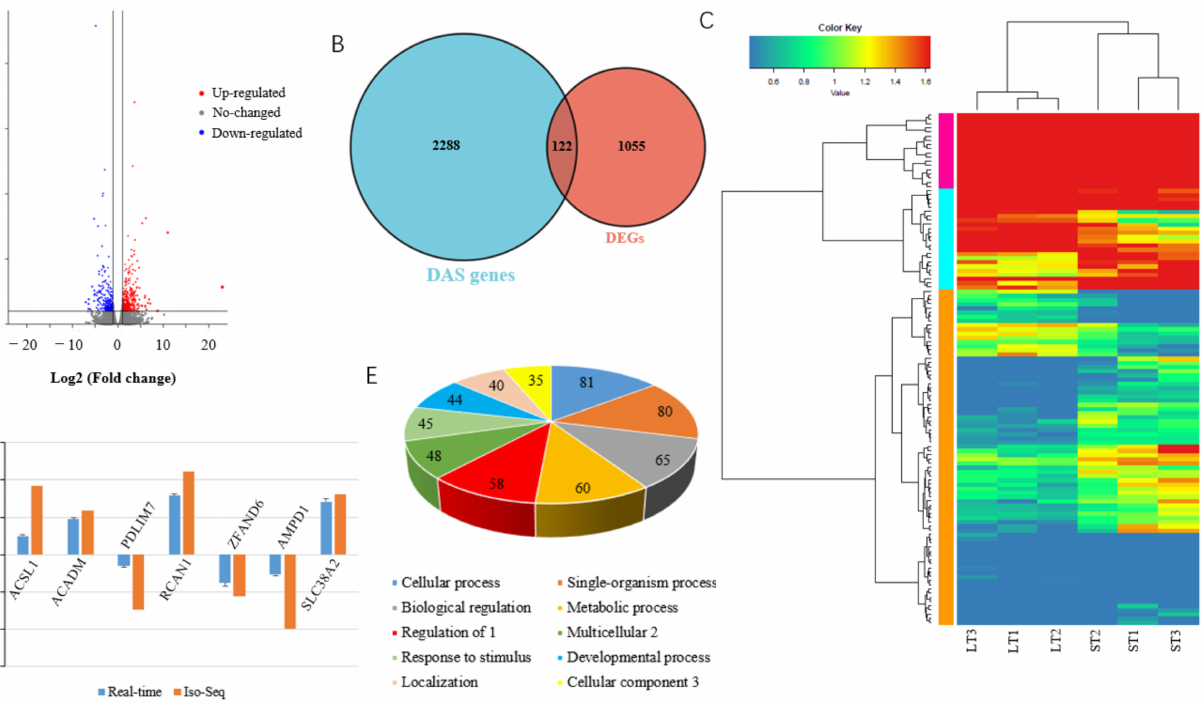
Figure 5. Characterization of differentially expressed (DE) differential alternative splicing (DAS) genes in semitendinosus compared to longissimus thoracis muscle. ( A ) Volcano plot of DE genes; ( B ) Venn diagram depicting DE-DAS and DE genes; ( C ) heatmap of DE-DAS genes; ( D ) real-time PCR validation of DE-DAS genes; ( E ) top 10 biological process categories classified by DE-DAS genes. The gene number is given in the chart. 1, Regulation of biological process; 2, multicellular organismal process; 3, cellular component organization or